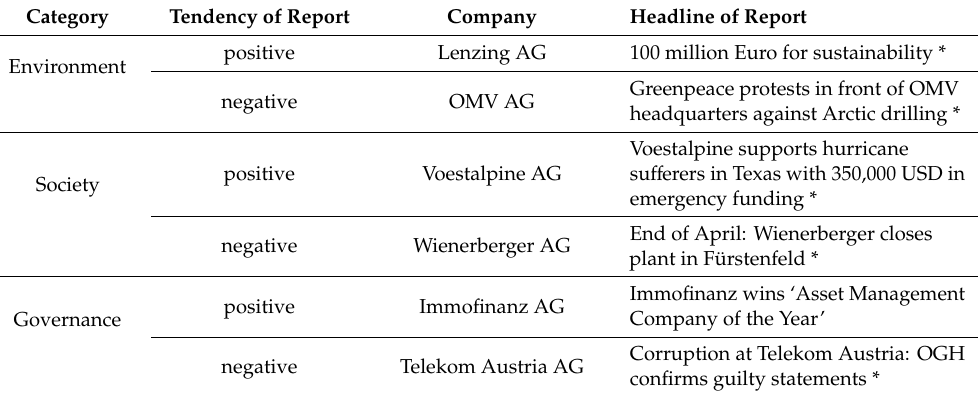
Table 8. Examples of CSR-relevant reports.